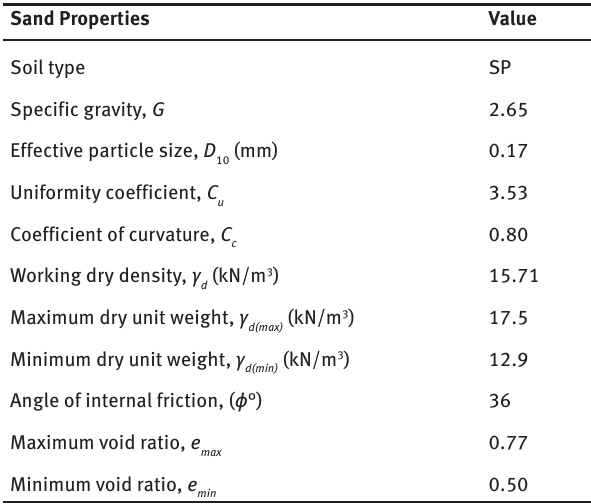
Table 1: Properties of Yamuna sand. Sand Properties